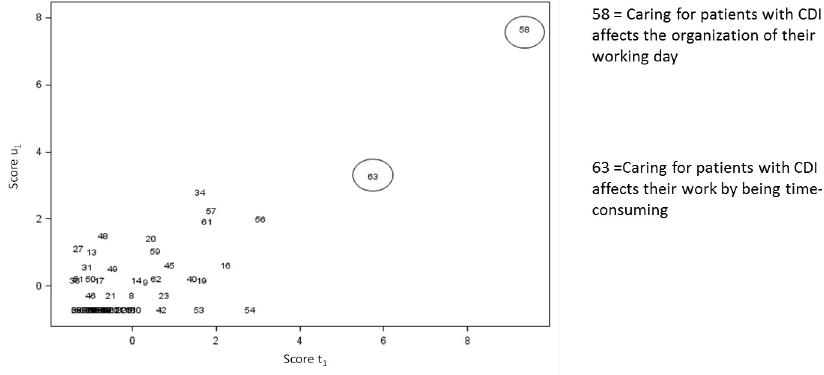
Fig 4. Projection of the themes in the space of the predictor score (t1) and the response variable scores (u1) according to the first PLS factor (N =